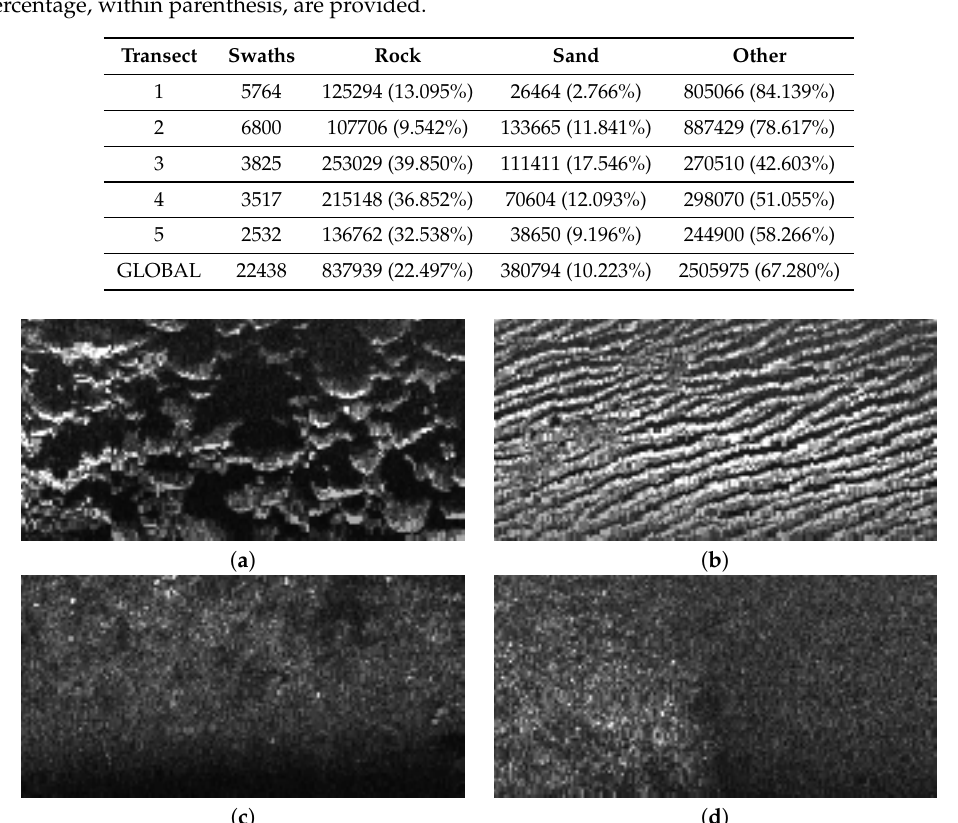
Figure 10. Examples of the three considered classes: ( a ) rock, ( b ) rippled sand and ( c , d )